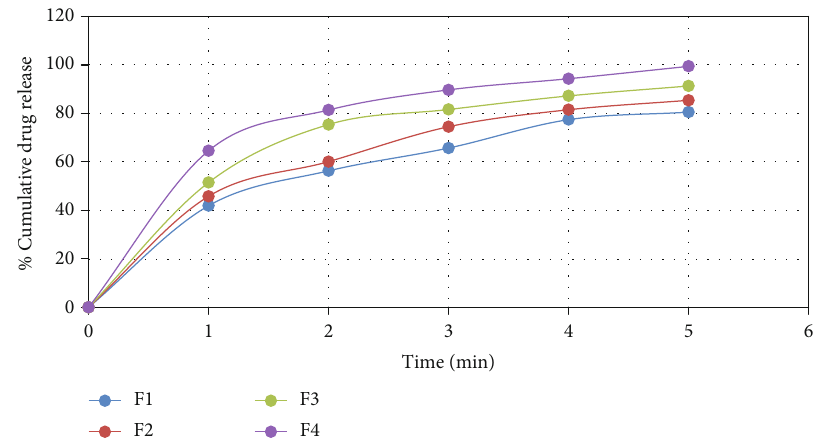
Figure 2: In vitro dissolution pro fi le of formulations (F1-F4).